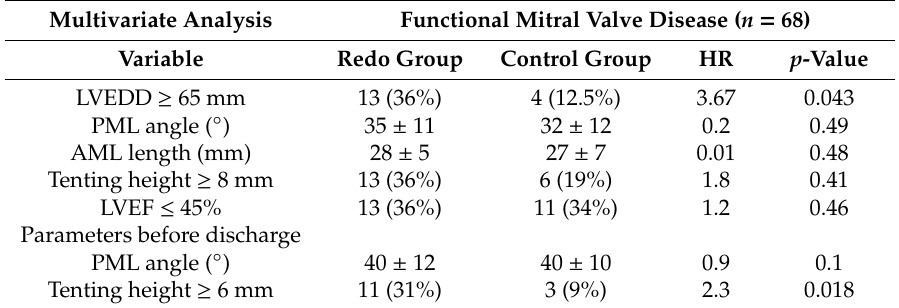
Table 4. Echocardiographical risk factors prior to initial mitral valve repair for redo MV surgery in the functional mitral regurgitation (FMR) subgroup (Cox regression